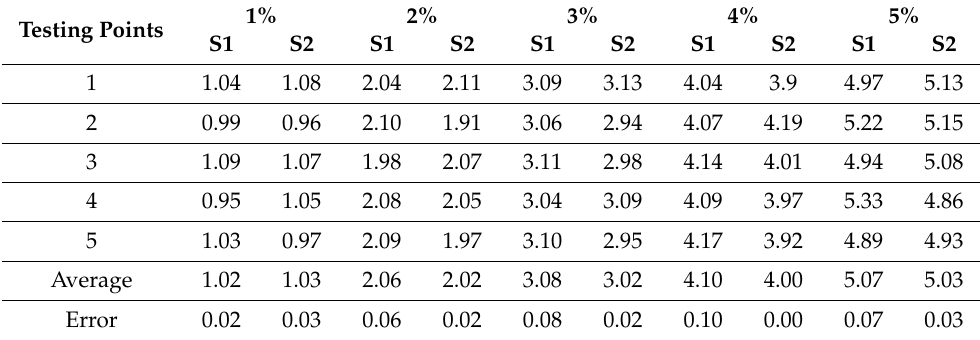
Figure 2. SEM images for Al (1050) alloy at different Mg content percentiles: ( a ) 1%; ( b ) 3%; ( c ) 5%. Table 2. Mg content percentiles.